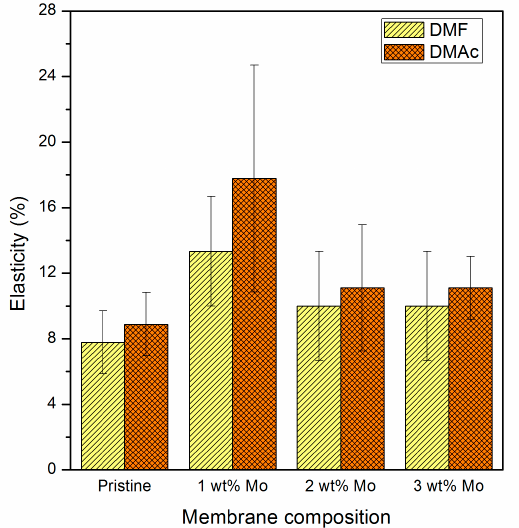
Figure 6. Membrane sheet elasticity based on various materials composition.